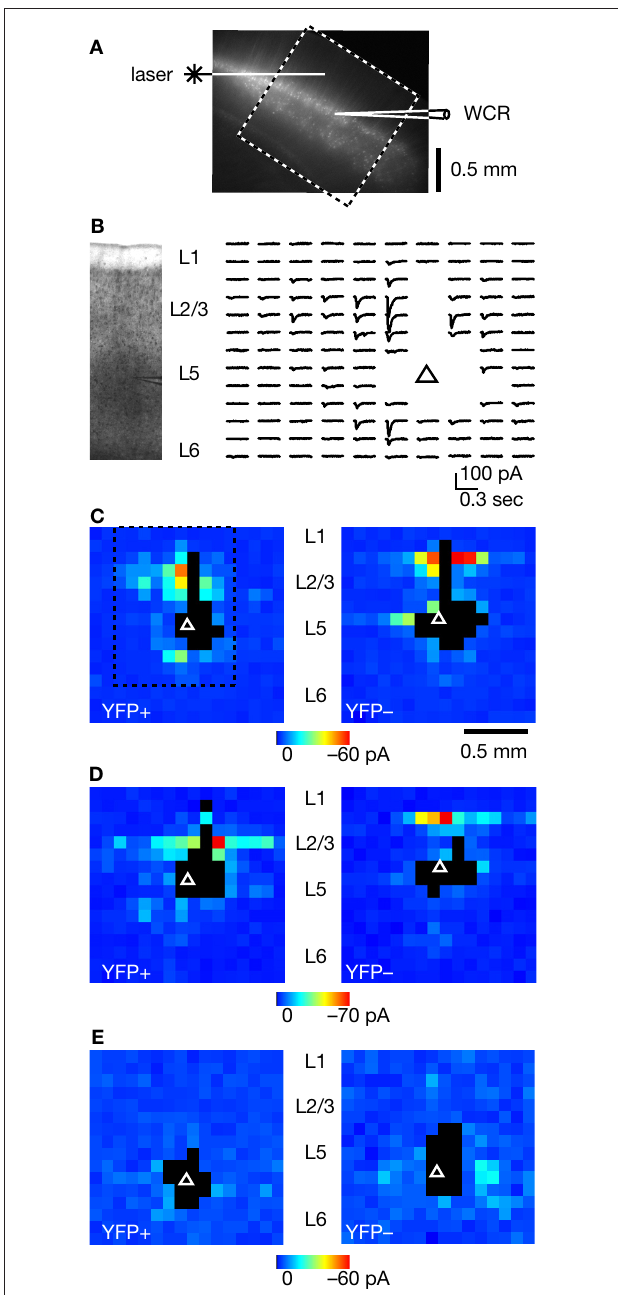
FIGURE 2 | Examples of LSPS maps of excitatory synaptic inputs to YFP-positive and YFP-negative layer 5 neurons. (A) Depiction of recording arrangement, illustrating laser beam, mapping area (dashed boxed), and recording electrode. (B) A portion of a typical LSPS trace map, showing synaptic responses evoked at different sites around the neuron ( , soma). Gaps are where traces were excluded due to direct dendritic stimulation; such sites are rendered as black pixels in maps. Image on left shows bright-fi eld appearance of slice. (C) Example of input maps for a pair of YFP-positive (left) and YFP-negative (right) neurons in upper layer 5, from the same slice. The dashed box indicates the pixels corresponding to the traces shown in (B) . The color bar applies to both maps. (D) Another example; note predominance of layer 3 input to the YFP-positive neuron, and layer 2 input to the YFP-negative neuron. (E) Examples of maps for neurons in lower layer